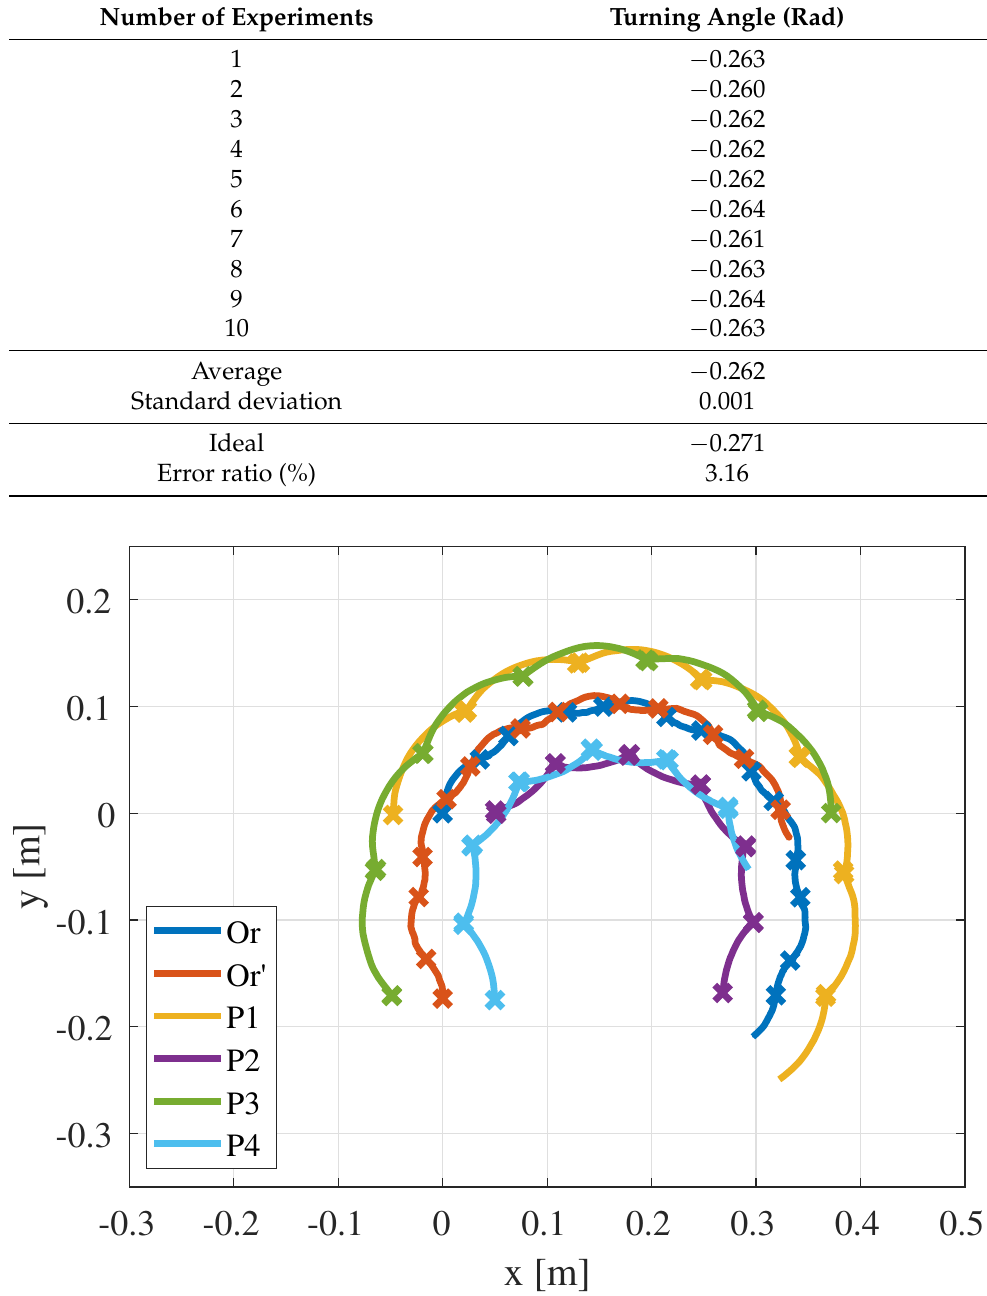
Table 6. The results of the clockwise turning locomotion experiments.